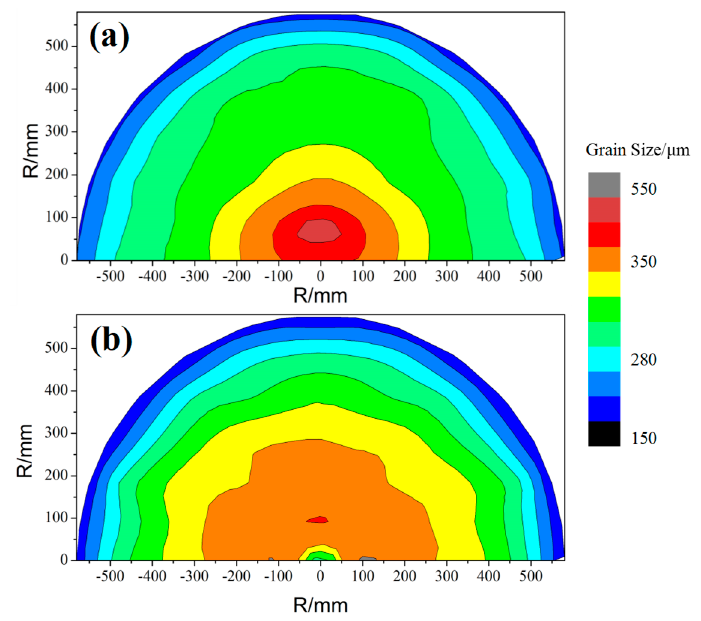
Figure 6. Comparison of the microstructures comprising the cross-sections of the two ingots. ( a ) Ingot I, ( b ) ingot II.